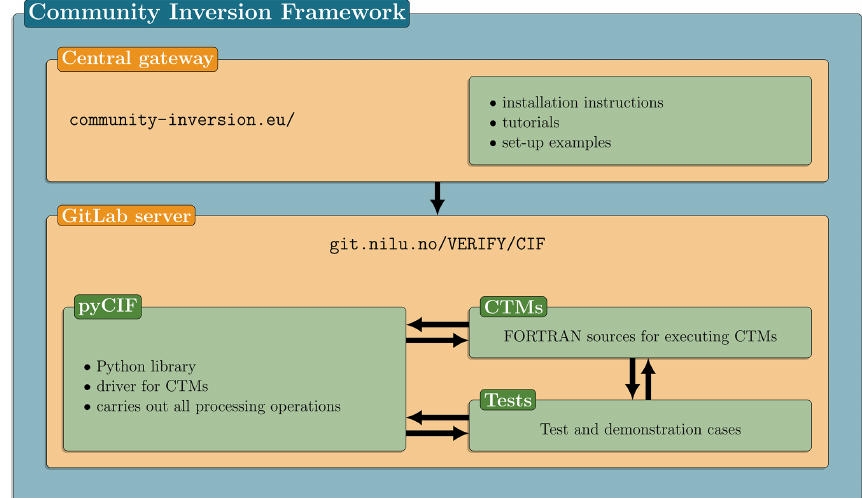
Figure 3. Organization of the Community Inversion